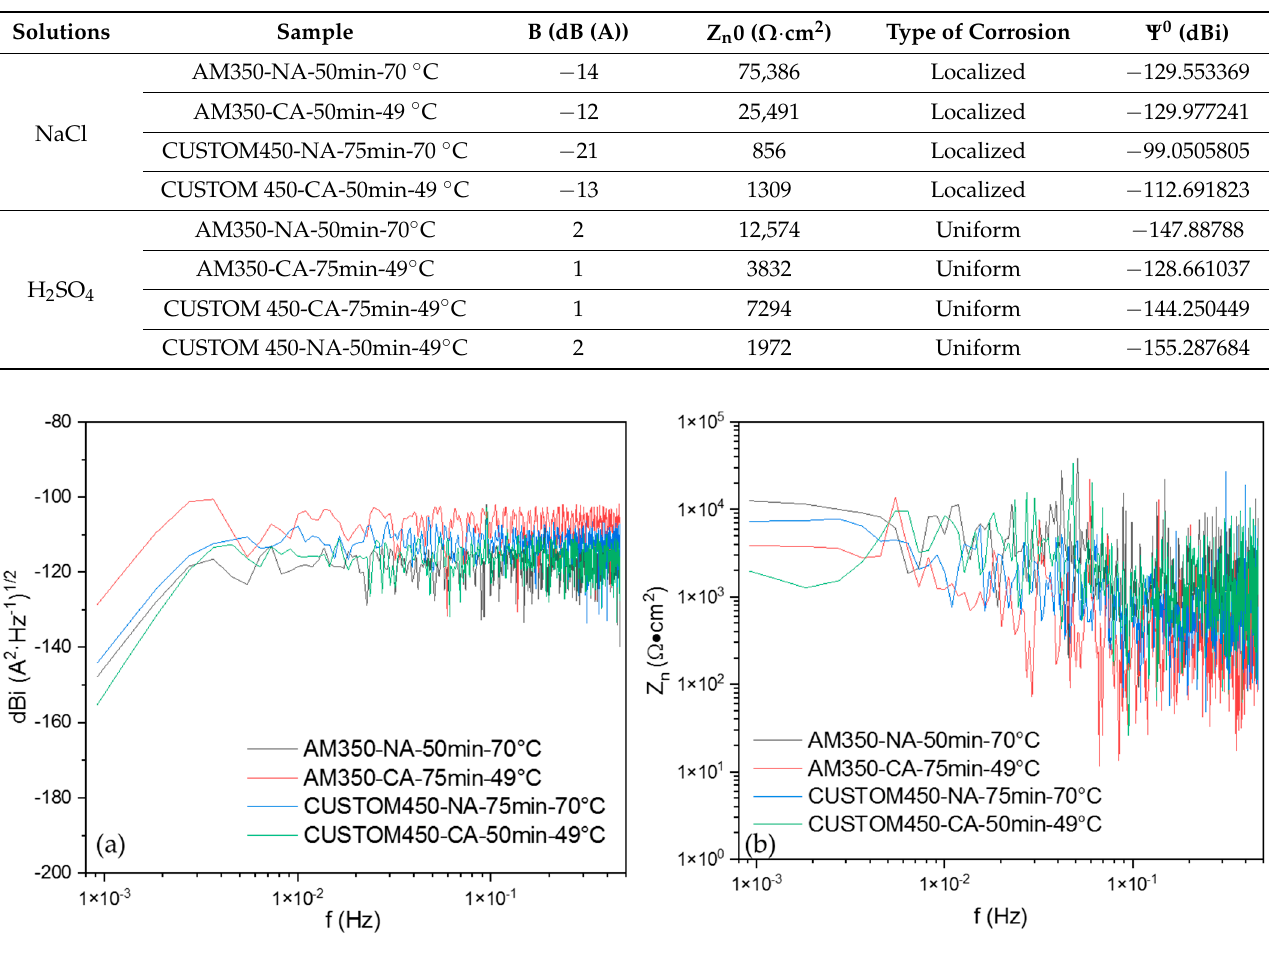
Figure 4. ( a ) Power spectral density (PSD) and ( b ) noise impedance (Z n ) for CUSTOM 450 and AM 350 passivated stainless steels immersed in 1 wt. % H 2 SO 4 solution.